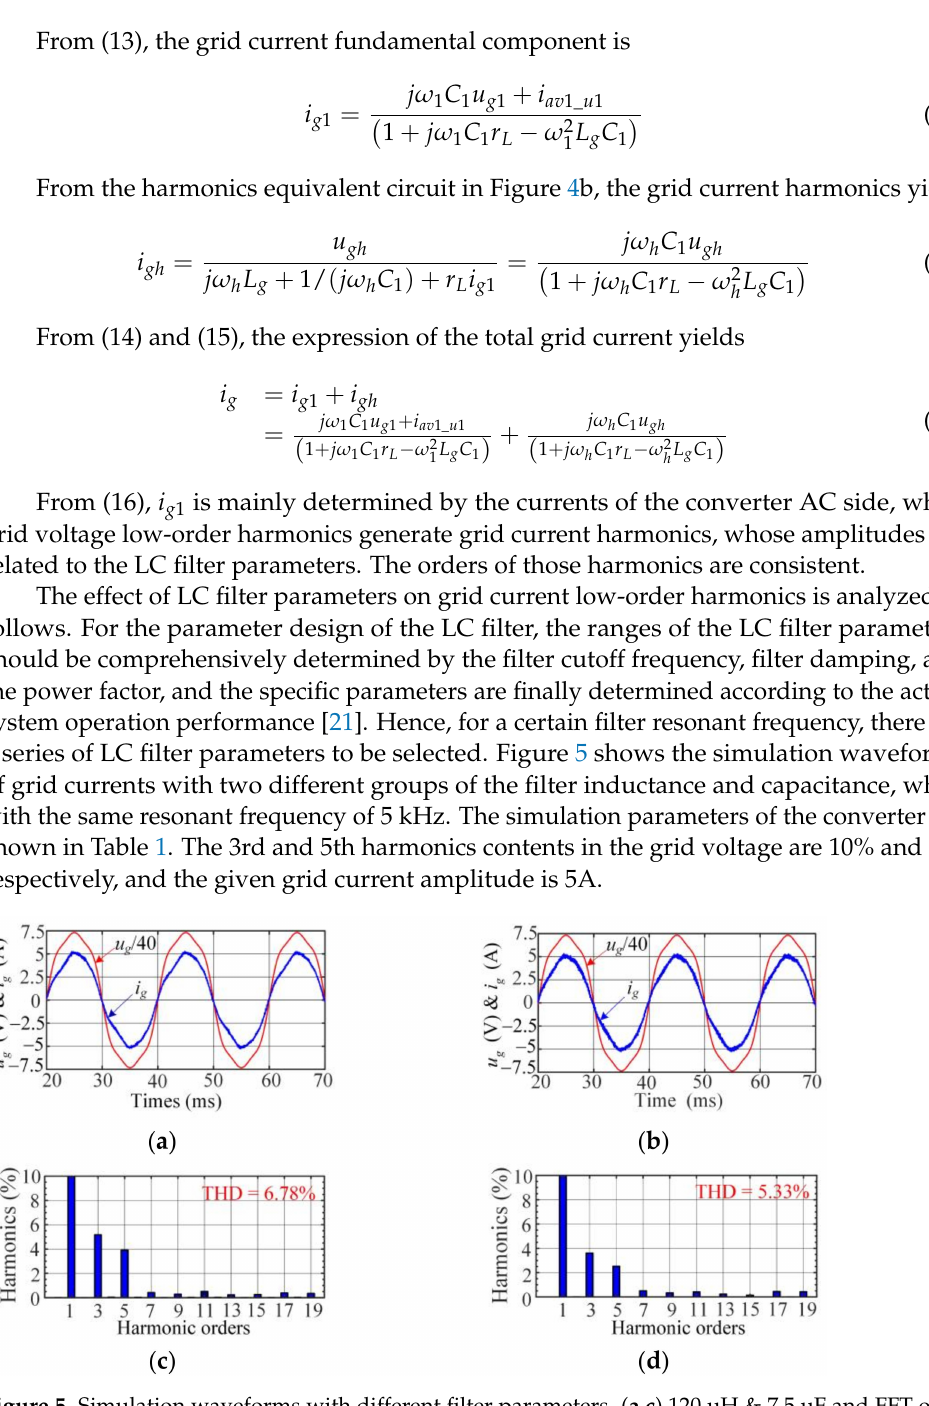
Figure 5. Simulation waveforms with different filter parameters. ( a , c ) 120 uH & 7.5 uF and FFT of ig, ( b , d ) 180 uH & 5 uF and FFT of